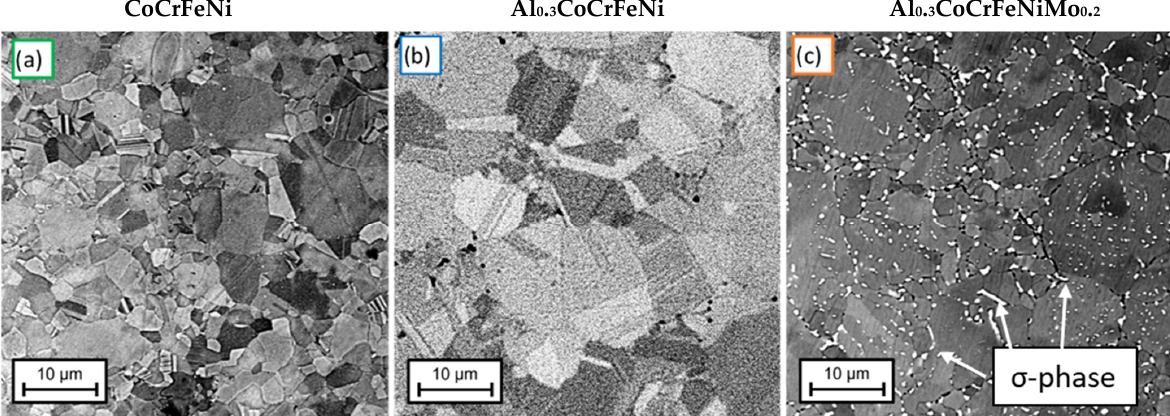
Figure 1. EBS images of the microstructure of ( a ) CoCrFeNi, ( b ) Al 0 . 3 CoCrFeNi, and ( c ) Al 0 . 3 CoCrFeNiMo 0 . 2 SPS-fabricated MPEA.